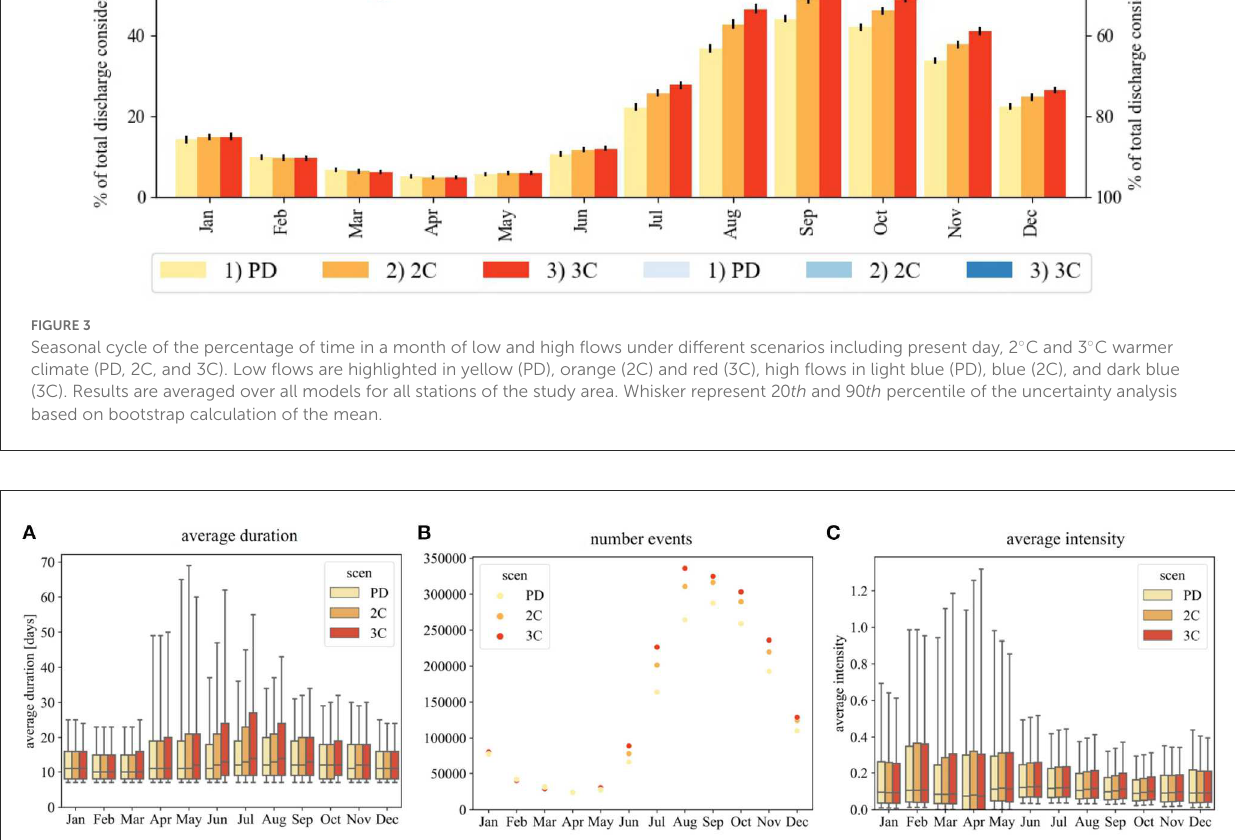
FIGURE4 (A) Average low flow duration, (B) number of events and (C) average intensity based on different months in which low flow periods started for PD, 2C and 3C scenario (based on national and model average). Low flow events are defined by the 20 th percentile threshold, lasting a minimum of 7 days. The number of events is total over the full ensemble in a scenario. Average intensity is normalized by the annual mean discharge of the stations included. Whiskers represent 10 th and 90 th